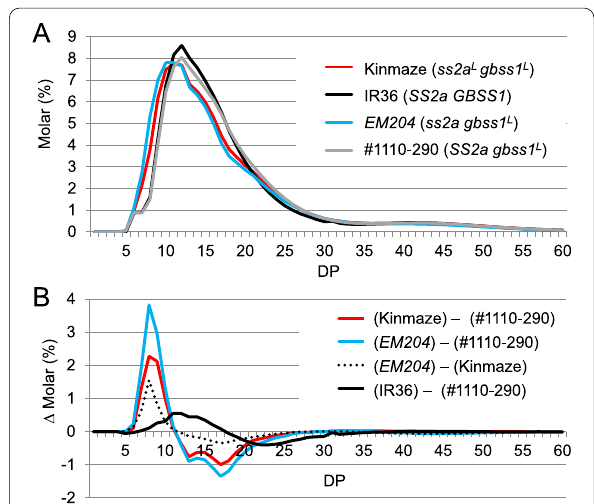
Fig. 1 Analysis of the molecular structure of amylopectin by capillary electrophoresis. A Chain-length distribution patterns of amylopectin in mature rice endosperm. B Differential plots of Kinmaze ( japonica rice; ss2a L gbss1 L ), EM204 ( ss2a mutant; ss2a gbss1 L ), and line #1110-290 (expressing indica -type SSIIa; SS2a gbss1 L ). Each panel shows a typical representative data set of at least three replications. DP, degree of polymerization. Data were obtained from Miura et